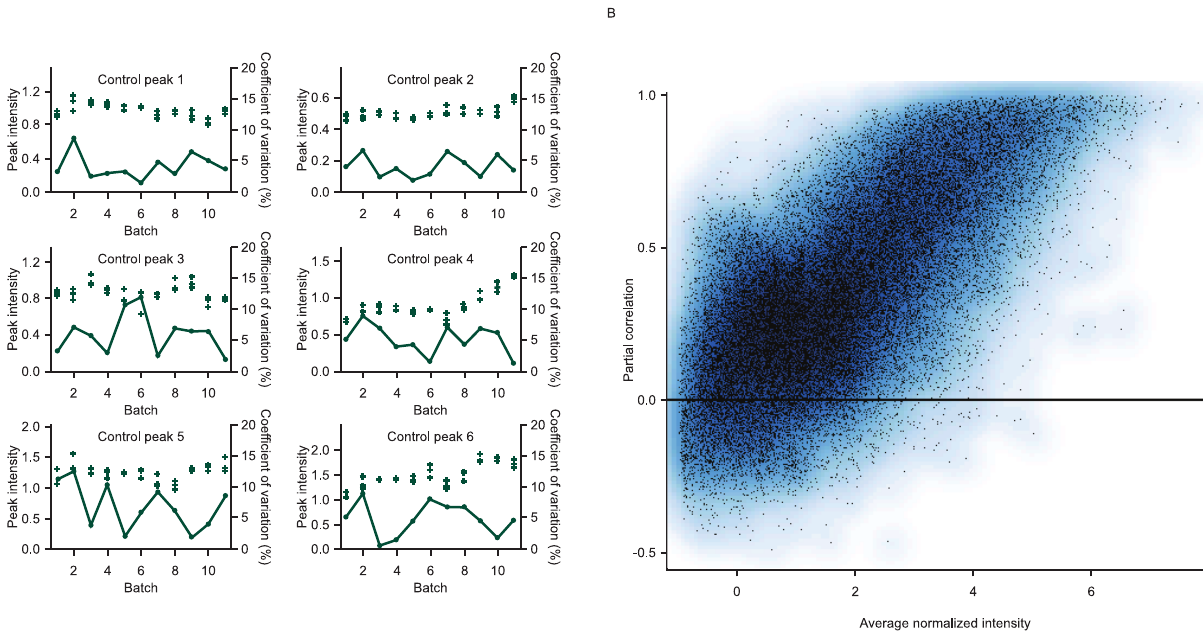
Figure 1. Quality control: reproducibility of control samples and sample duplicates. (A) Reproducibility of 6 control peaks for the 3 standard quality control samples, plotted as ‘ + ’, in each analysis batch (peak intensity, left axis). The coefficients of variation (%, right axis) between the 3 control samples in each batch are plotted as points joined by a line. (B) Reproducibility of peptide intensities for 39 samples with duplicate analyses in different analysis batches. Partial correlation, after removing between batch differences, plotted against the average normalized intensity for each peptide. Higher intensity peptides show high reproducibility in their intensities between repeated batches.